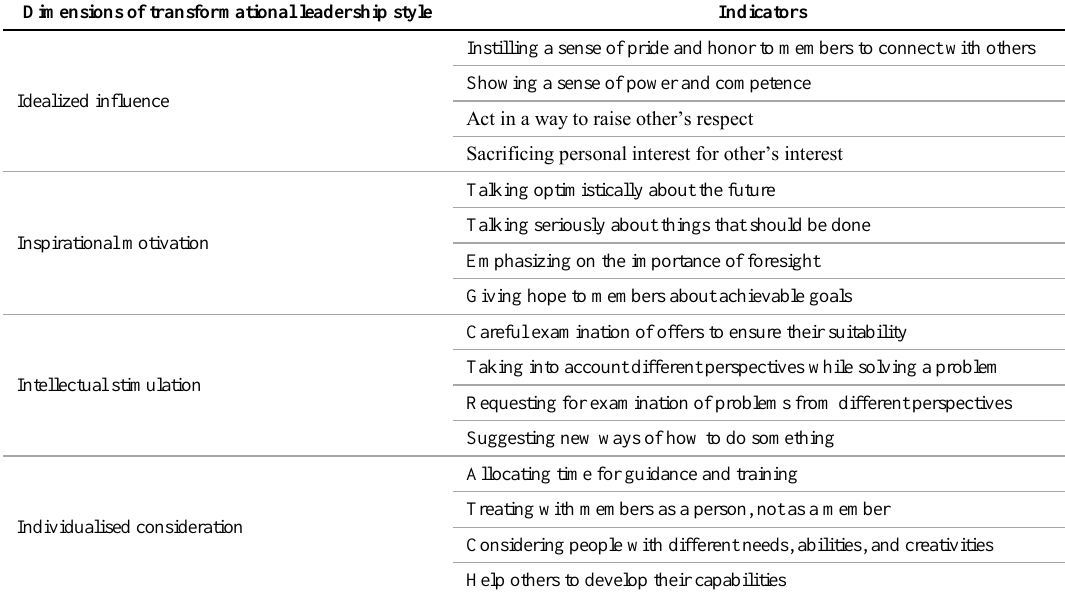
Table 1. Dimensions of transformational leadership from the perspective of Bass and Avolio (1994)